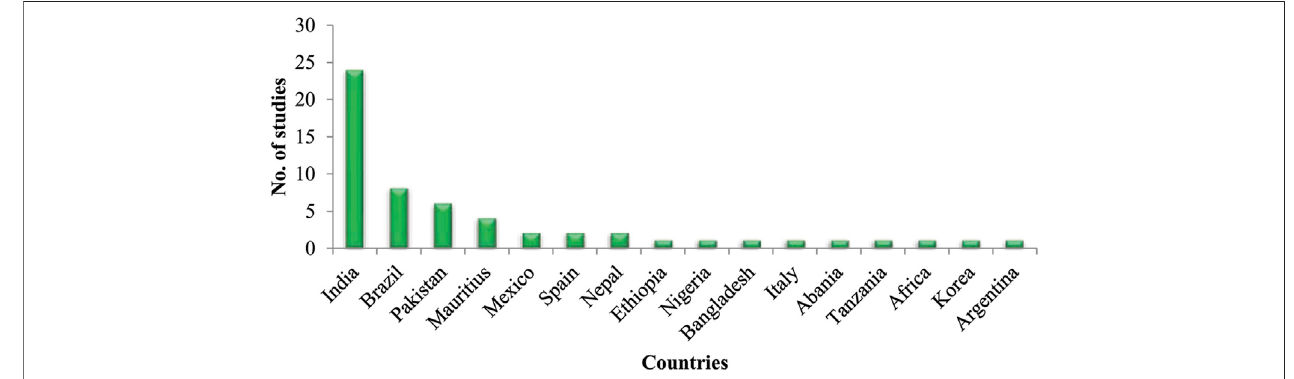
FIGURE 2 | Number of ethnozoological studies conducted throughout the